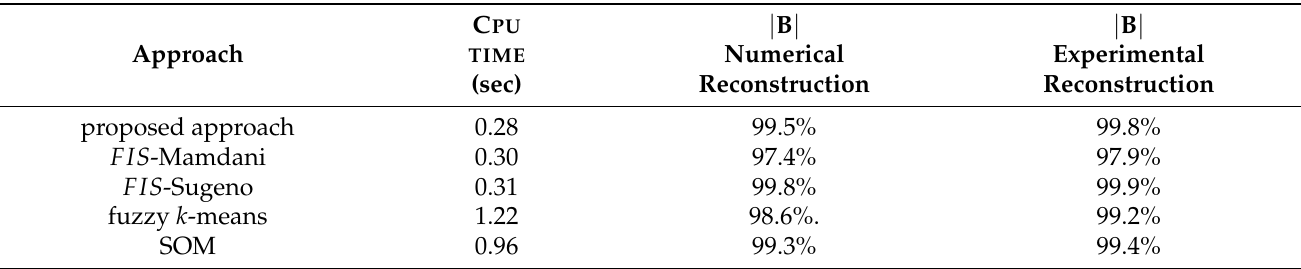
Table 11. Numerical EC map classification performance: fuzzy proposed approach versus stan- dard